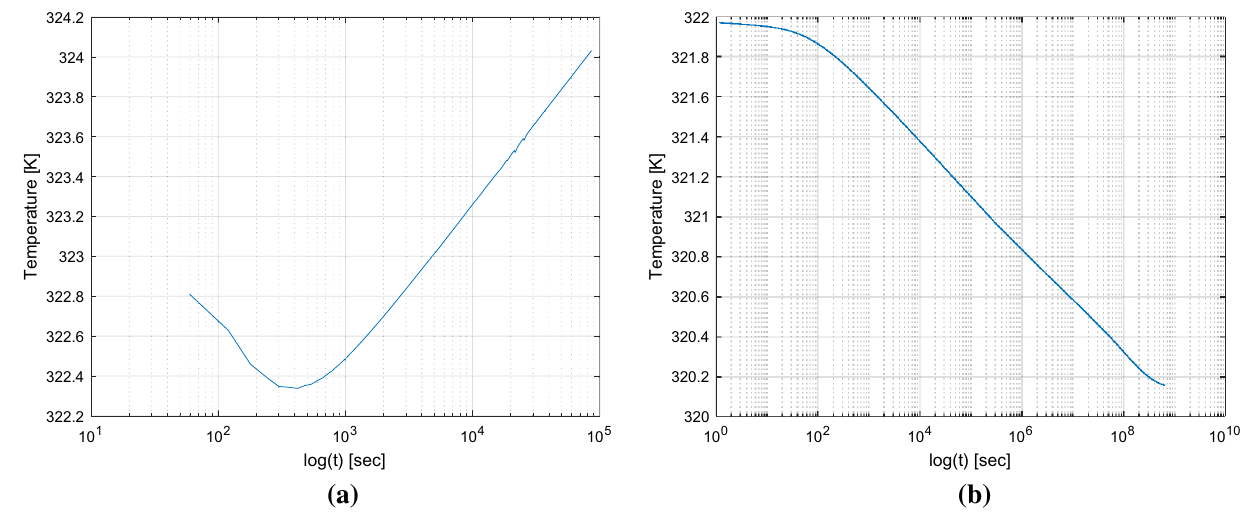
Fig. 1 Plot of numerical transient wellbore temperature a for a liquid producing well b for a gas producing well